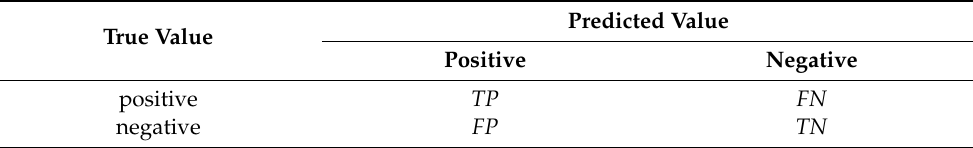
Table 2. The detailed explanation of TN , TP , FN , and FP